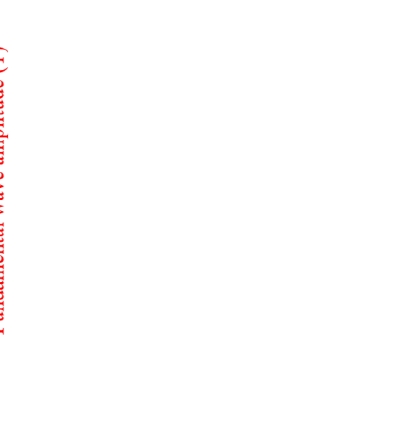
Figure 6. Relationship between THD and fundamental wave amplitude of Air−gap flux density and eccentricity.